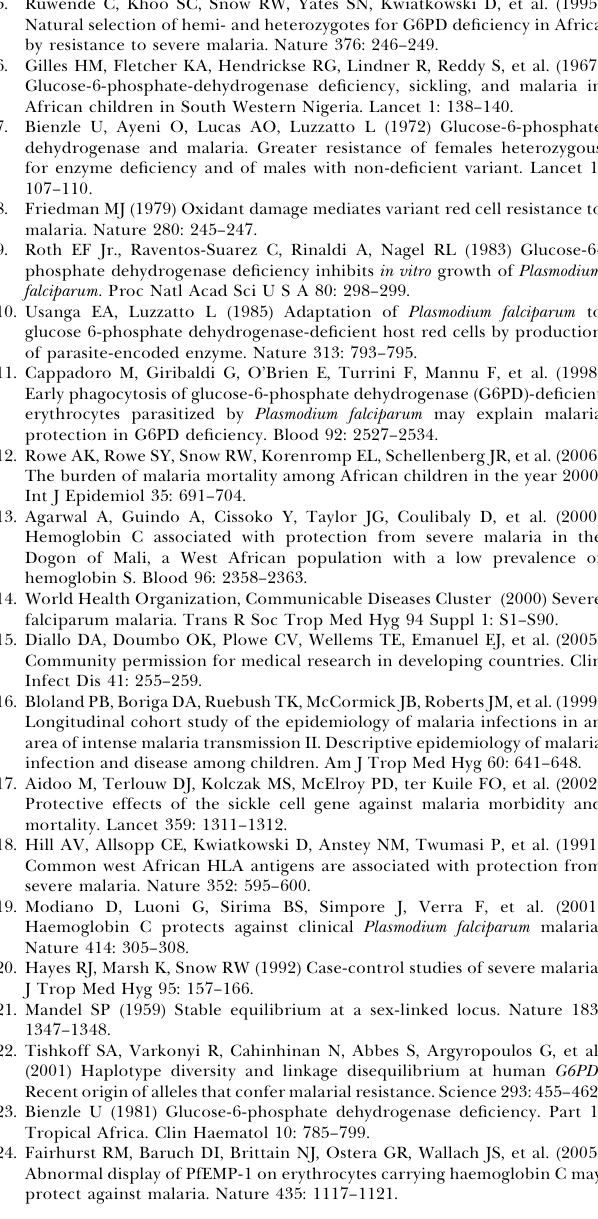
Table S1. DistributionofUncomplicatedandSevereMalariaCasesina Previously Reported Case-Control Study from The Gambia and Kenya Data from Ruwende et al . [5] were used in stratified analysis to calculate pooled ORs for the protective effect of the A (cid:2) form of G6PD deficiency in hemizygous males and heterozygous females against severe malaria. Found at doi:10.1371/journal.pmed.0040066.st001 (50 KB DOC). Table S2. Distribution of Uncomplicated, Cerebral, and Severe Anemia Malaria Cases in the Present Study and in a Previously Reported Case-Control Study from The Gambia and Kenya Data from the present study (Table 1) and from Ruwende et al. [5] were used in fixed effects meta-analysis to calculate pooled ORs for the relative protection of the A (cid:2) form of G6PD deficient males and females against cerebral malaria and severe anemia. Found at doi:10.1371/journal.pmed.0040066.st002 (74 KB